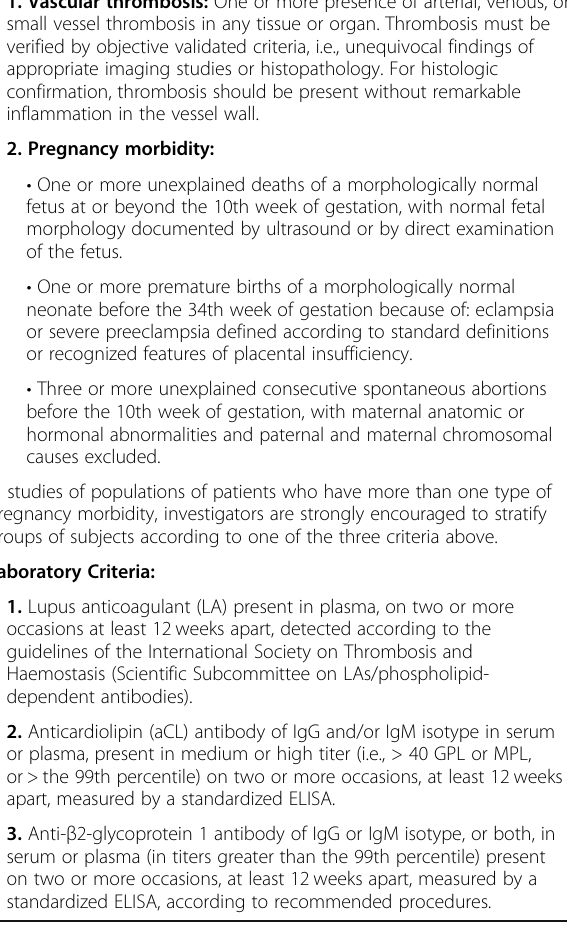
Table 1 Revised Sapporo criteria for the